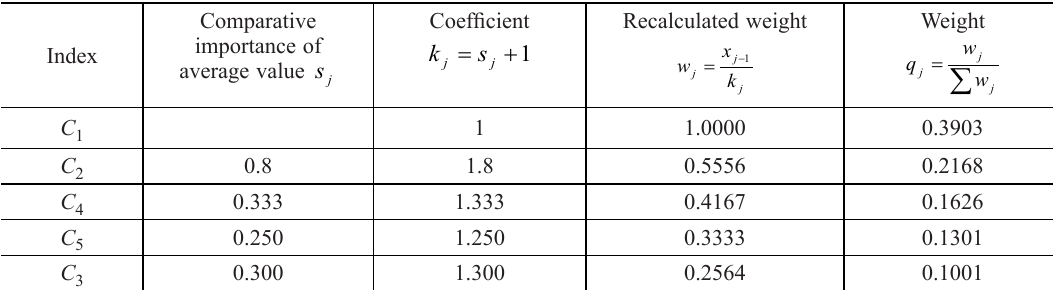
Table 4. Priorities and final weight of indexes of the architecture